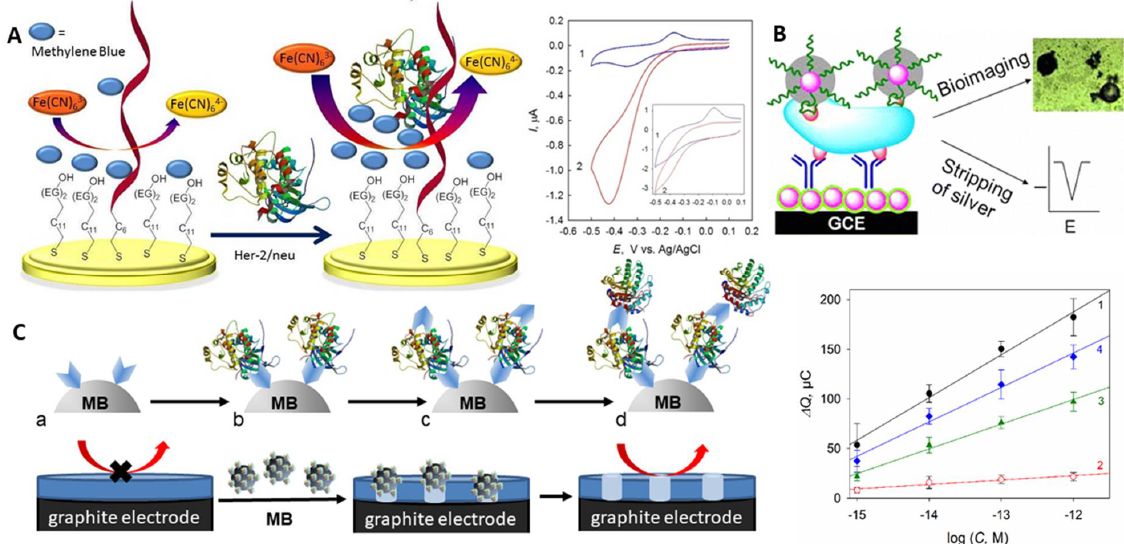
Figure 4. ( A ) Schematic representation of the electrocatalytic aptamer/PEG-based assay for HER-2/ neu and voltammograms recorded with the aptamer/PEG-modified electrode in (1) MB and (2) MB and K 3 [Fe(CN) 6 ] solutions, scan rate 0.1 V s −1 (inset: 5 V s −1 ) [103]. Specific binding sites and change of the aptamer conformation upon binding are not shown. ( B ) Silver-enhanced hybrid sandwich immunoassay with hydrazine-modified AuNP tags [105]. ( C ) Cellulase-linked sandwich immunoassay on MBs modified ( a ) with a capture antibody or an aptamer, ( b ) HER-2/ neu , ( c ) a reporter antibody or aptamer and ( d ) cellulase, and dependence of the sensor response on the concentration of (1,3,4) HER-2/ neu and (2) serum albumin for (1,2) Ab-(protein)-Ab-MBs, (3) aptamer-(protein)-Ab-MBs, and (4) aptamer-(protein)-aptamer-MBs sandwiches [107]. Copyright (2017) Wiley, copyright (2013) American Chemical Society and copyright (2019) Elsevier, reprinted with permissions.